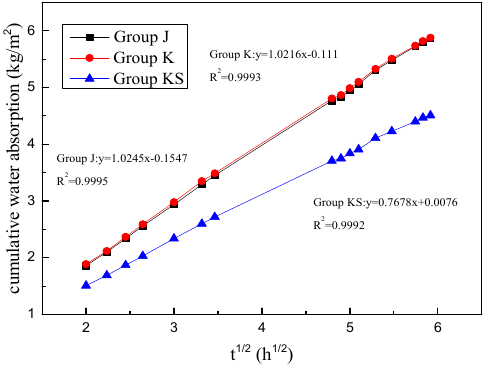
Figure 3. Fitting result of early stage.